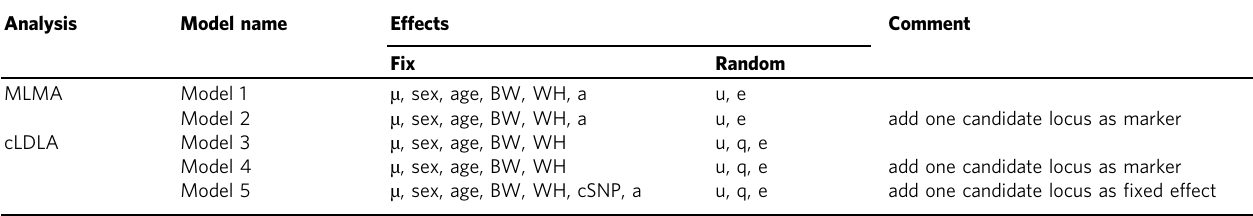
Table 1 Mixed linear models used for association and combined linkage disequilibrium and linkage analysis.